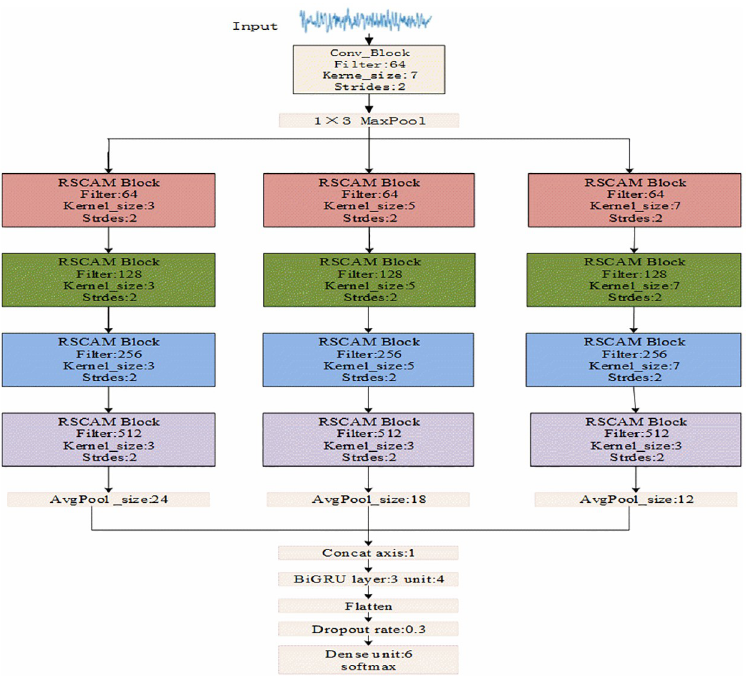
Fig 6. Overall structure of the